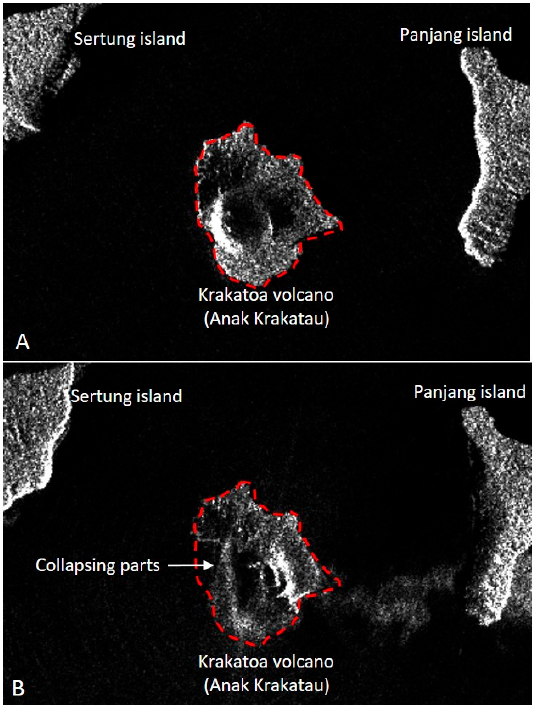
Figure 4. Comparison of the Sentinel images (https://apps.sentinel-hub.com/eo-browser/ (accessed on 27 December 2020)) pre ( A ) and post-eruption ( B ) of Krakatoa in December 2018. The red-dashed line marks the initial volcanic island, and the white arrow shows the area of collapse (after Ref. [58]).